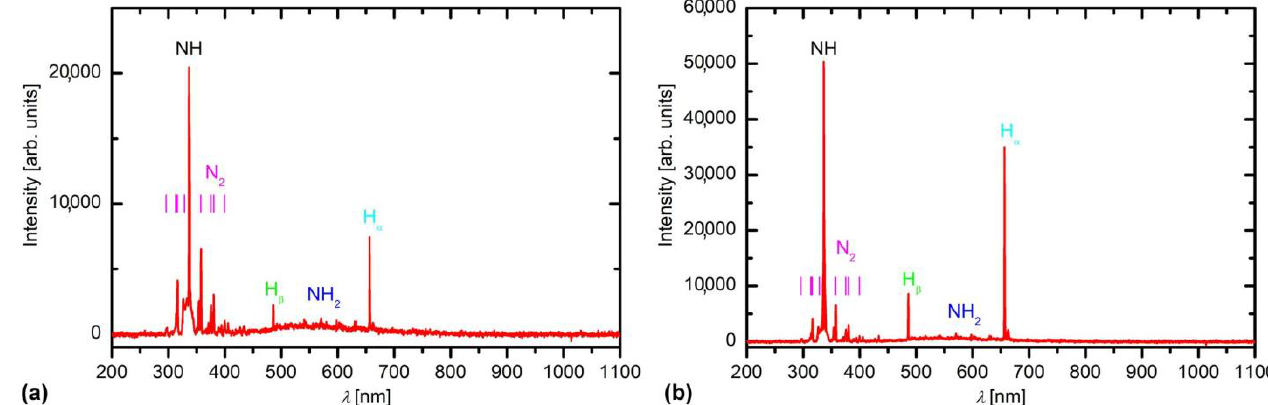
Figure 3. The optical spectrum during the treatment of a PTFE with ammonia plasma at the power of: ( a ) 200 W and ( b ) 25 W. The integration times were 0.05 and 10 s, respectively.